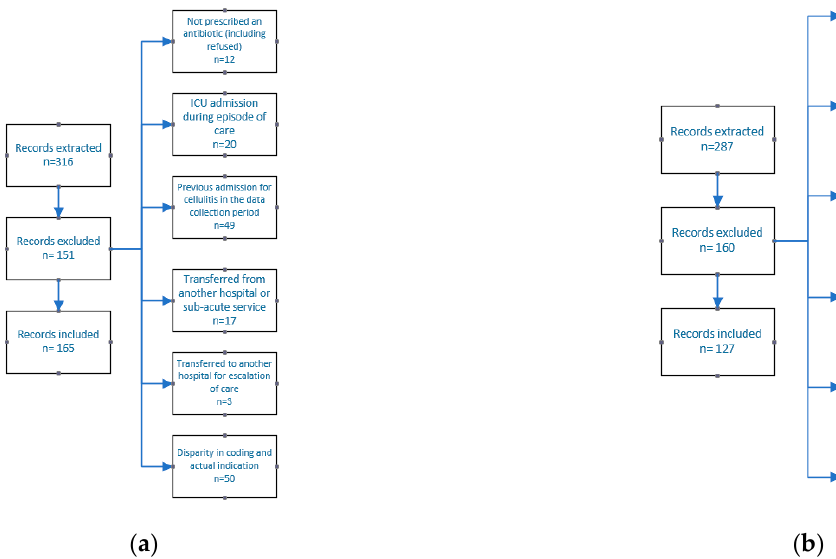
Figure 1. Reasons for exclusion from the sample: ( a ) baseline ( n = 165) and ( b ) post ‐ implementation sample ( n = 127).